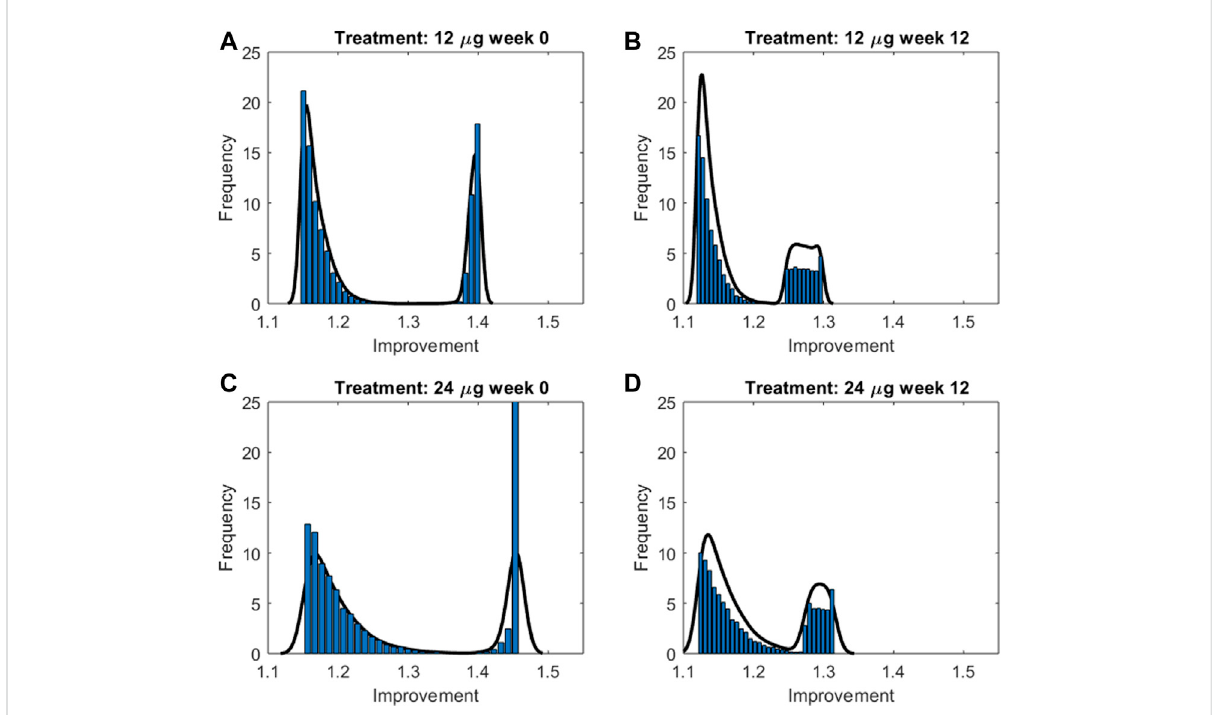
week 0 and 12 for double-blind treatment with formoterol 12g [panels (A,B) , respectively] and with formoterol 24;g [panels (C,D) , respectively].